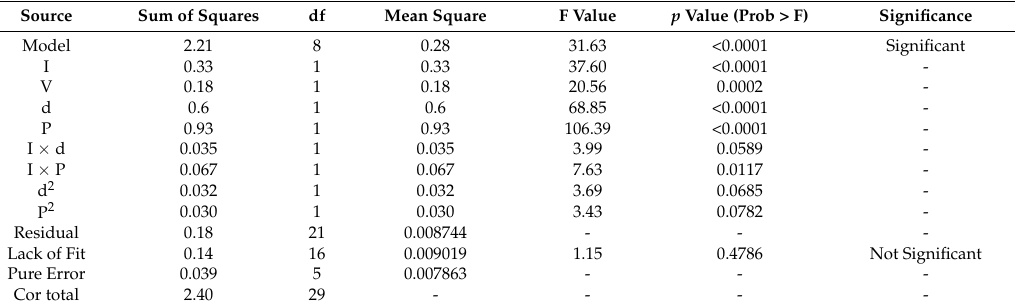
Table 5. Results of ANOVA for model of weld depth.